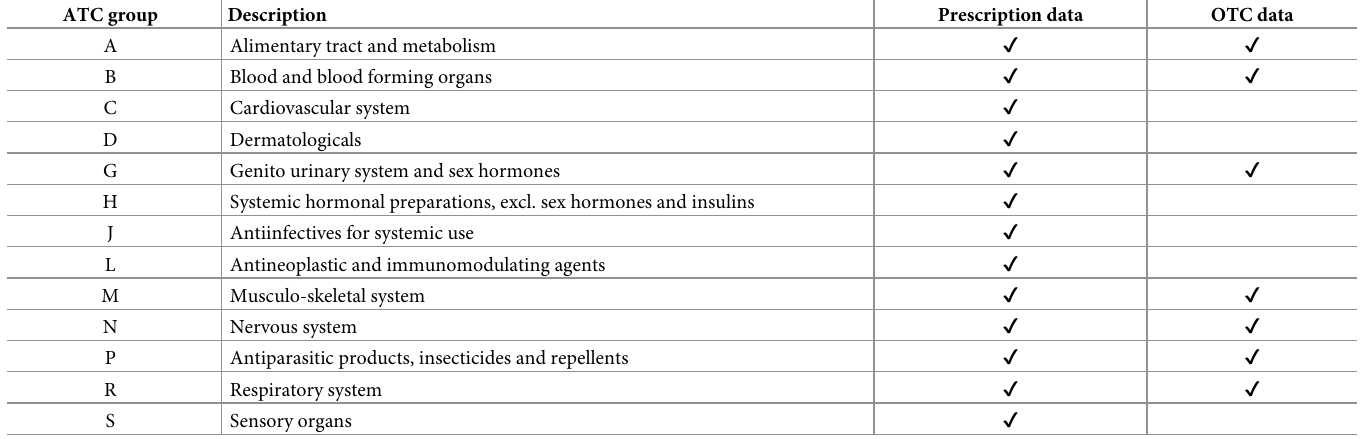
Table 1. Anatomical main groups of Anatomical Therapeutic Chemical (ATC) classification system included in the aggregated data for prescription dispensations and over-the-counter medication